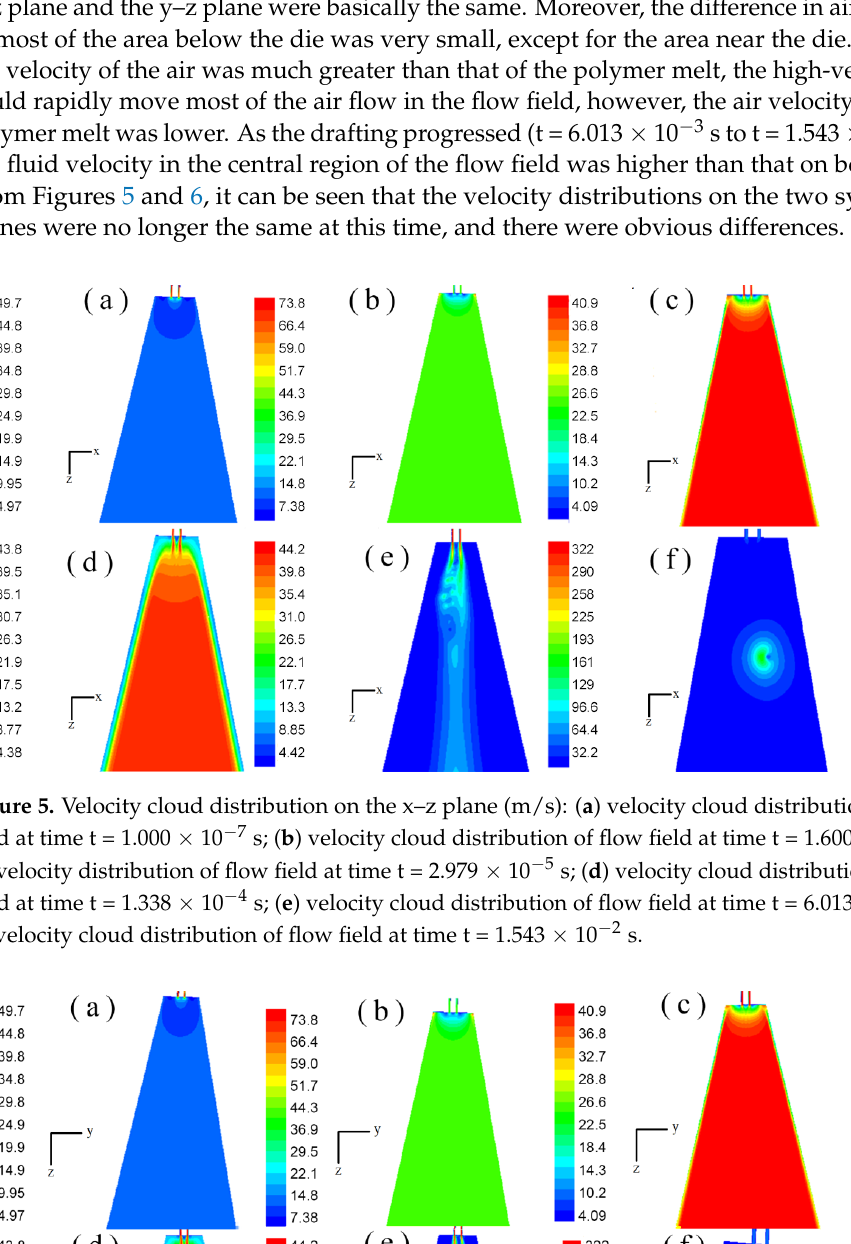
Figure 6. Velocity cloud distribution on the y–z plane (m/s): ( a ) velocity cloud distribution of flow field at time t = 1.000 × 10 − 7 s; ( b ) velocity cloud distribution of flow field at time t = 1.600 × 10 − 6 s; ( c ) velocity distribution of flow field at time t = 2.979 × 10 − 5 s; ( d ) velocity cloud distribution of flow field at time t = 1.338 × 10 − 4 s; ( e ) velocity cloud distribution of flow field at time t = 6.013 × 10 − 3 s; ( f ) velocity cloud distribution of flow field at time t = 1.543 × 10 − 2 s.